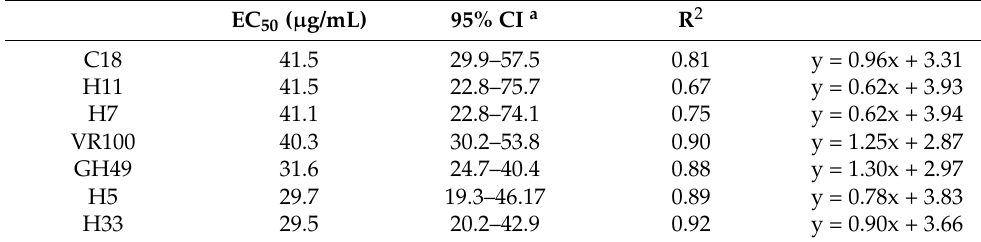
Table 3. Mancozeb mean EC 50 values (effective fungicide concentration that inhibited mycelial growth by 50%) for Phytophthora palmivora isolates from Ghana (GH49 and VR100), Mexico (C18), and Hawaii (H5, H7, H11, and H33) obtained from in vitro assays. No EC 50 values differed significantly among isolates, as determined by the overlap in confidence intervals. EC 50 ( µ g/mL) 95% CI